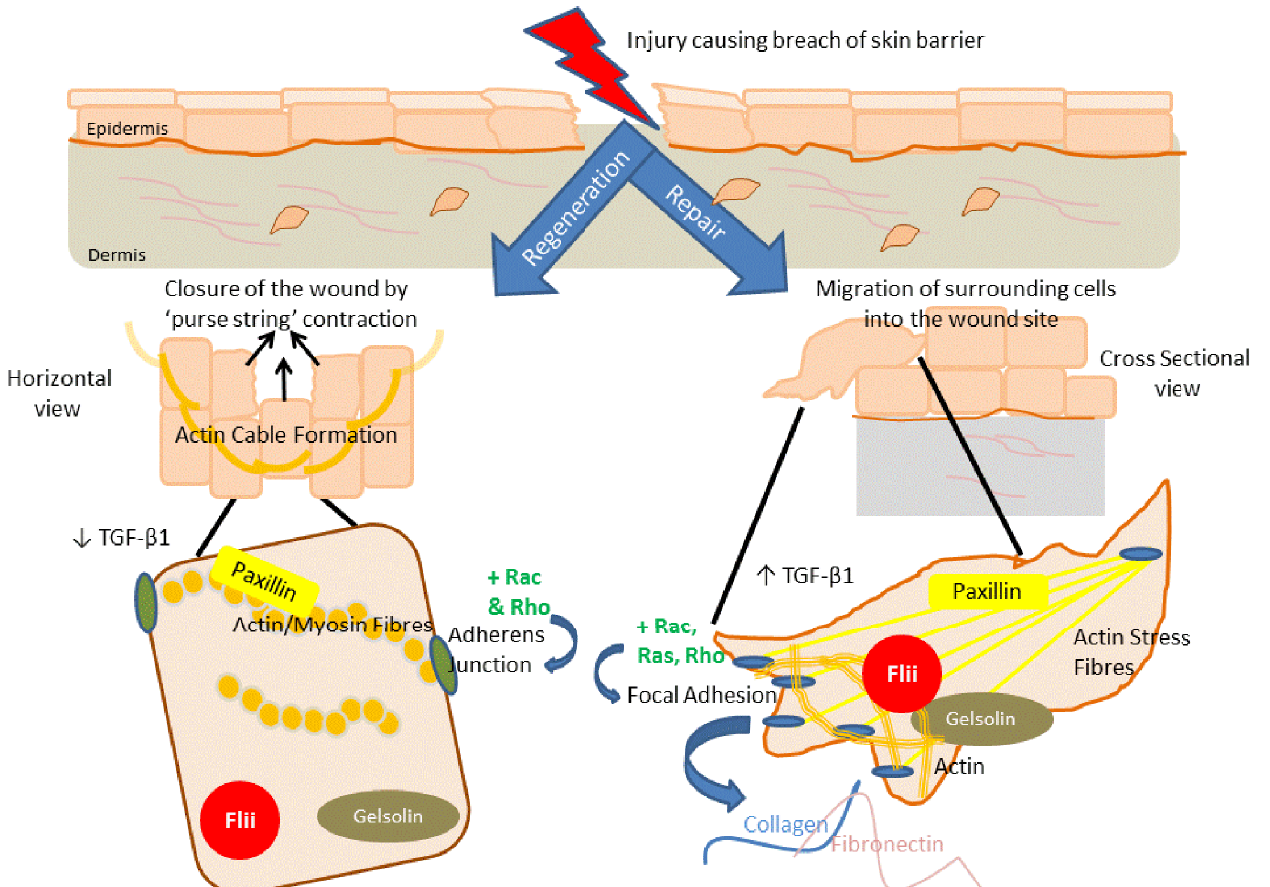
Figure 4. Schematic diagram of differences in actin cytoskeleton organisation and associated proteins in early gestation, regenerative healing compared to late gestation